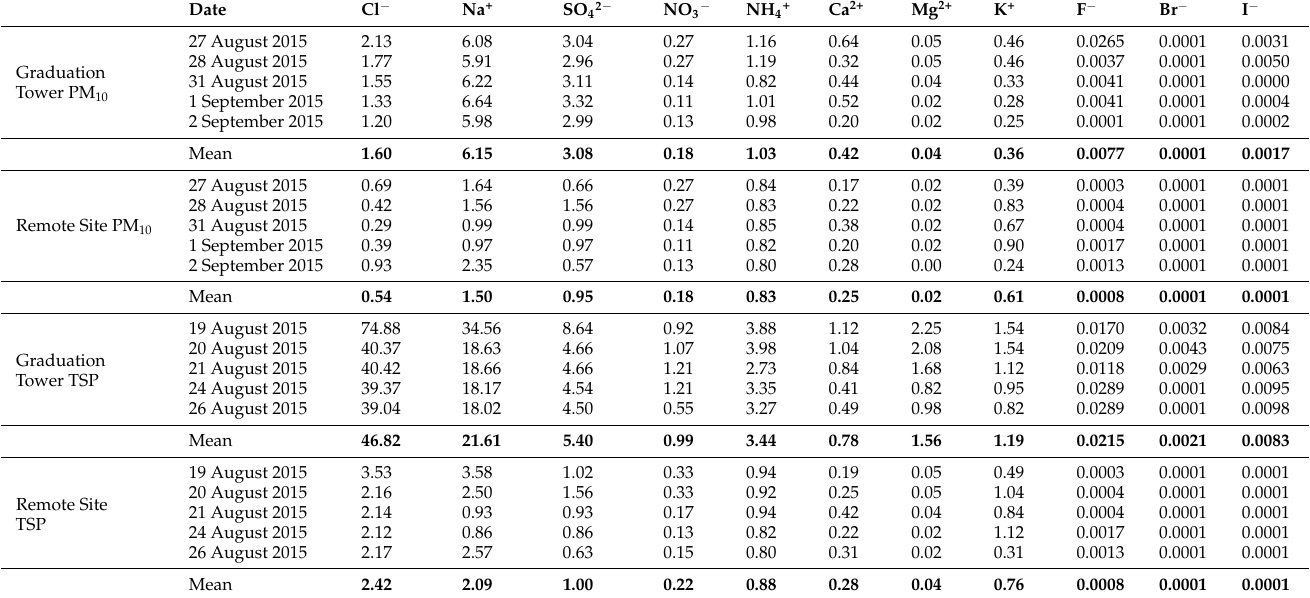
Table 2. Concentration ( µ g/m 3 ) of ionic components of water-soluble aerosol related to TSP and PM 10 in the five-day measurement periods.